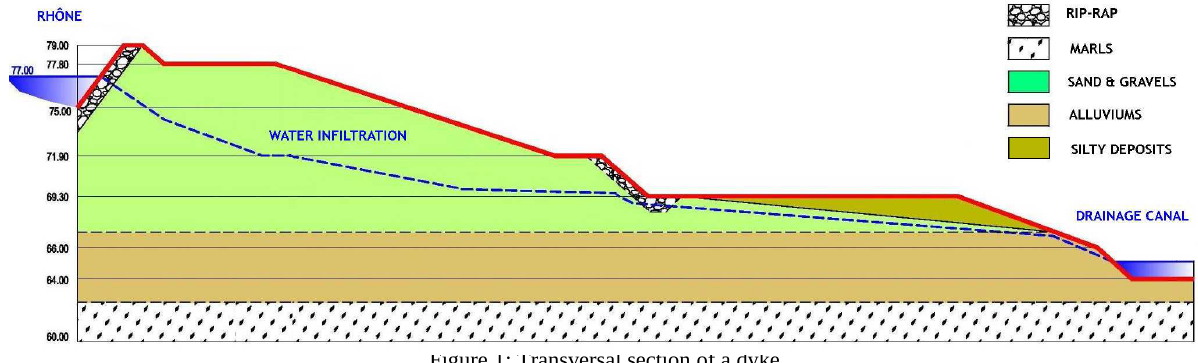
Figure 1: Transversal section of a dyke